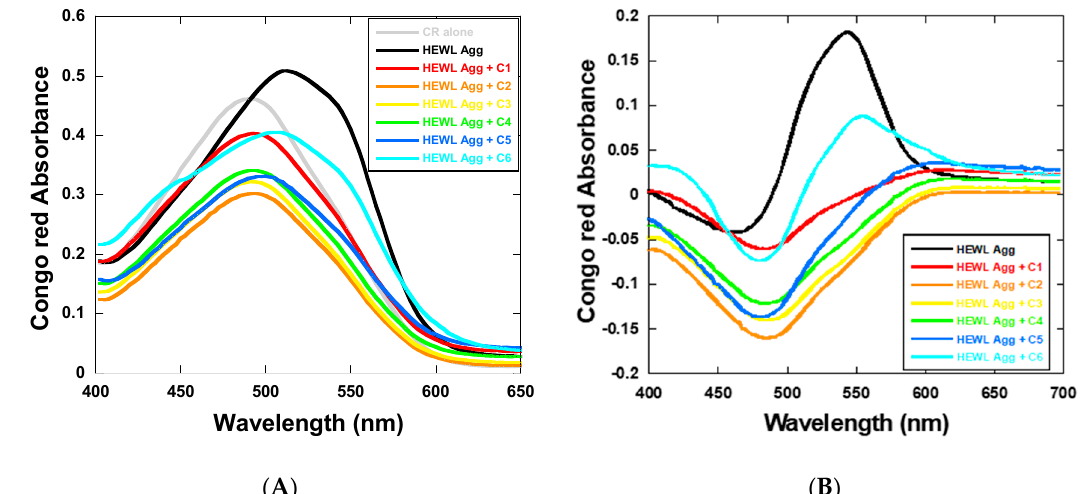
Figure 3. E ff ects of compounds 1 – 6 , at a concentration of 0.32 µ M, on HEWL aggregation at 2 mg / mL, 50 mM glycine bu ff er, pH 2.5, 57 ◦ C, under stirring (250 rpm), monitored by changes in CR absorbance after 48 h. ( A ) The spectra refer to CR alone (gray), HEWL pre-incubated under aggregating conditions without compounds (black), with compound 1 (red), compound 2 (orange), compound 3 (yellow), compound 4 (green), compound 5 (blue), and compound 6 (indigo). ( B ) Di ff erence spectra obtained by subtracting the spectrum of CR alone from the spectra of HEWL aggregates with CR reported in ( A ). Color code as in ( A